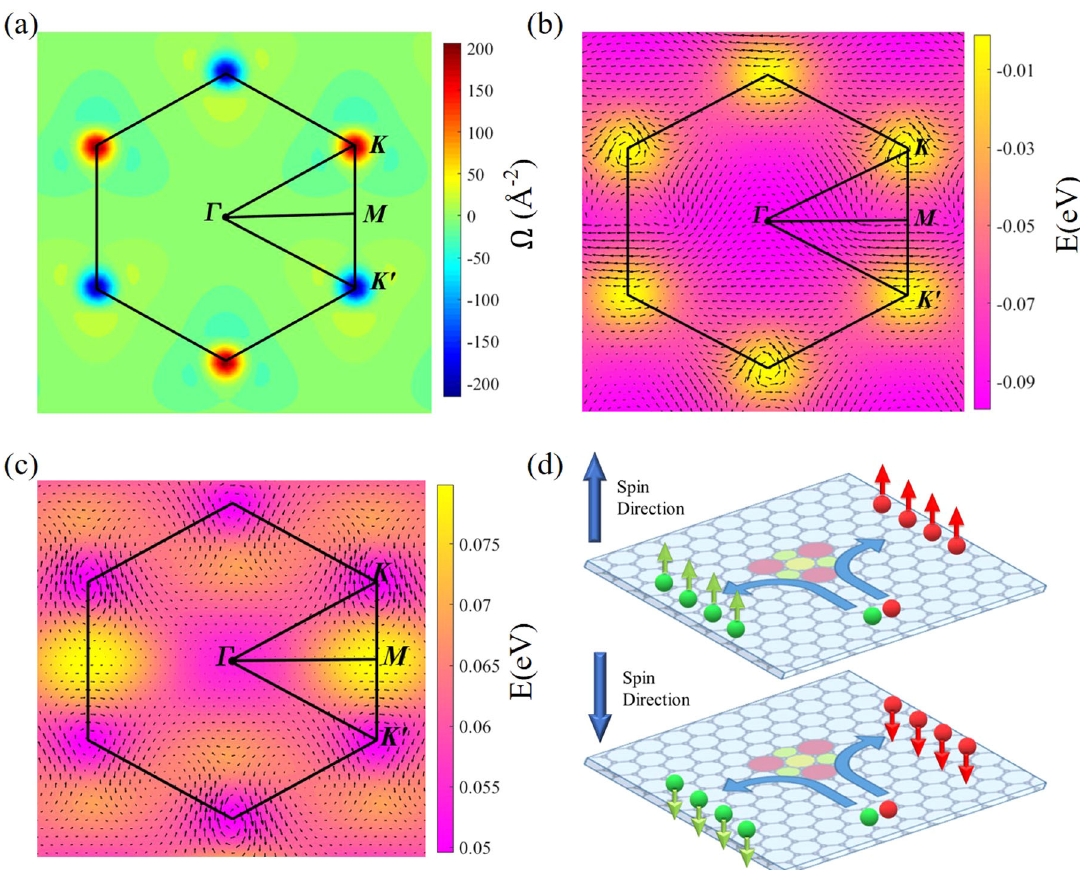
Fig. 4 The nature of Hall conductivity in C 2 . a The momentum resolved Berry curvature for the occupied bands. The fi rst BZ is denoted by the black hexagon, and the color code is in units of (Å − 2 ). In-plane spin textures for VBM ( b ) and CBM ( c ). The color scale refers to the band energy (eV) with respect to the Fermi level, and the relative strength of the in-plane spin fi eld S xy is represented by black arrows. d Schematic of the spin fi ltered VH